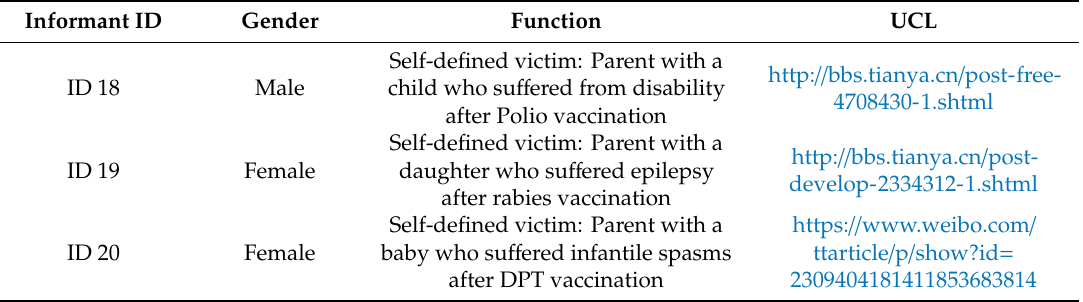
Table 2. Characteristics of online informants and descriptions of their